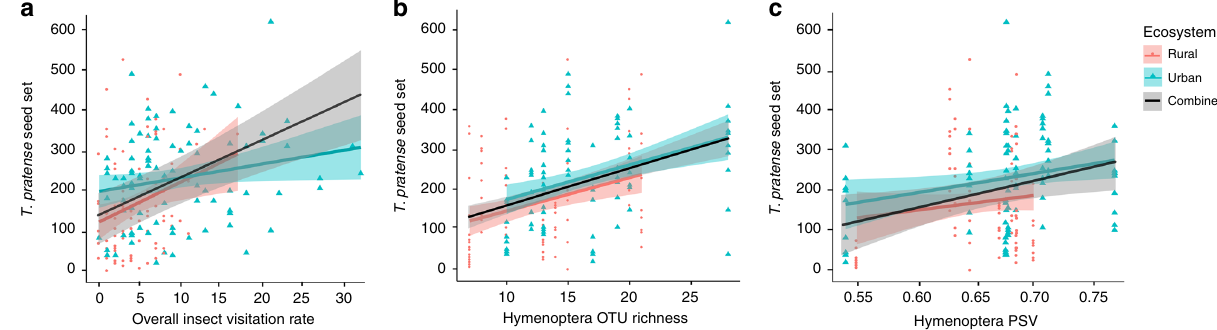
Fig. 6 Pollinator biodiversity and Trifolium pratense seed set. Relationships between T. pratense seed set (mean seeds per pollinometer plant) and a total visitation rate by all insects, b Hymenoptera OTU richness, and c Hymenoptera phylogenetic variability (PSV) across and within rural and urban sites ( N = 18 sites). Plotted lines show predicted relationships and the shaded areas indicate 95% con fi dence intervals. Red circles and blue triangles correspond to seed set in rural and urban sites, respectively. The plotted red and blue solid lines represent the predicted relationships within the rural and urban ecosystems, respectively. The plotted black solid line represents the predicted relationship across both ecosystems, rural and urban.